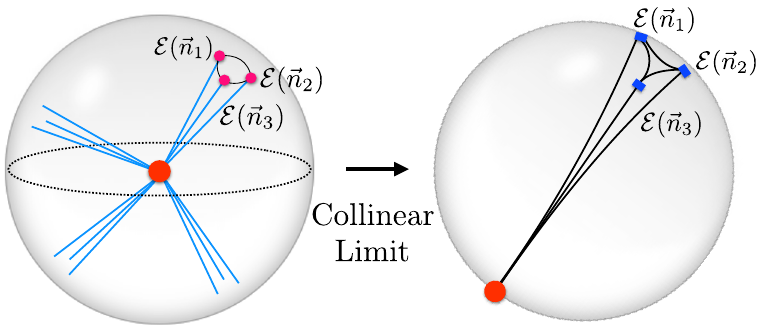
Figure 3. In the collinear limit, the EEEC factorizes onto a massless state, as shown in (cid:12)gure 2. The source therefore moves to the S 2 celestial sphere, and the EEEC exhibits the symmetries of a four point function on S 2